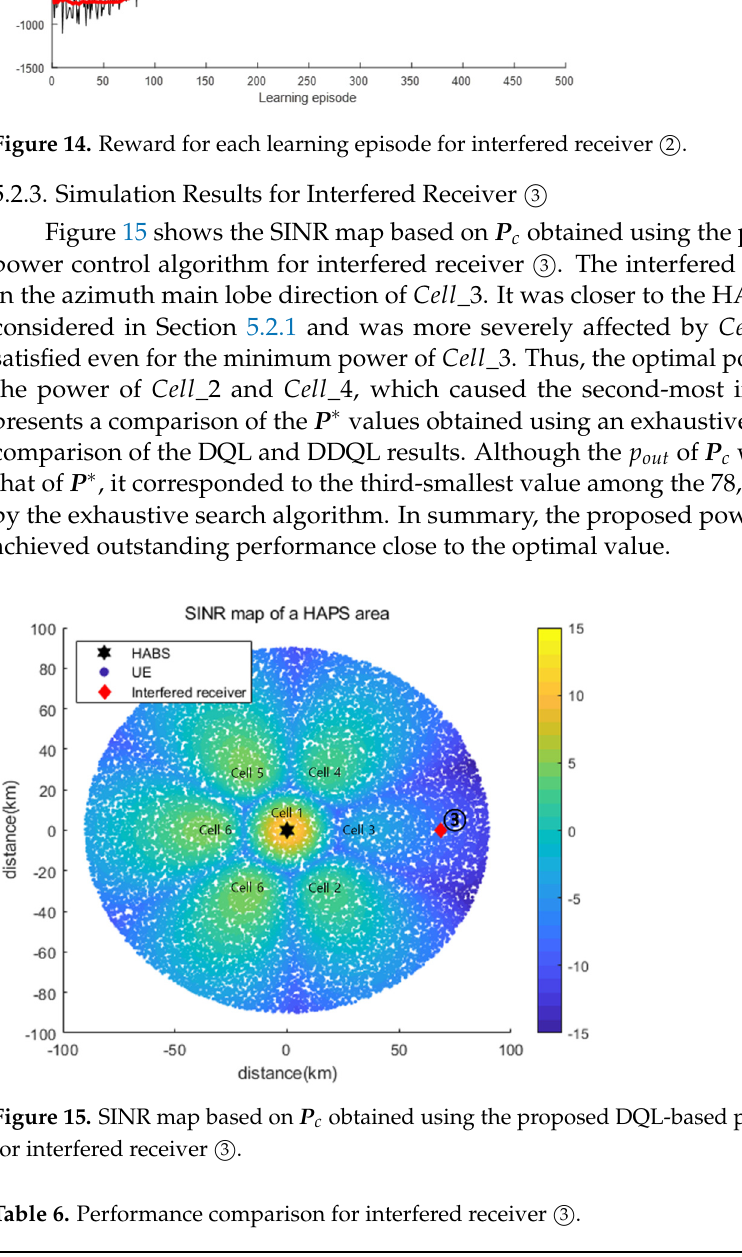
Figure 14. Reward for each learning episode for interfered receiver ② .